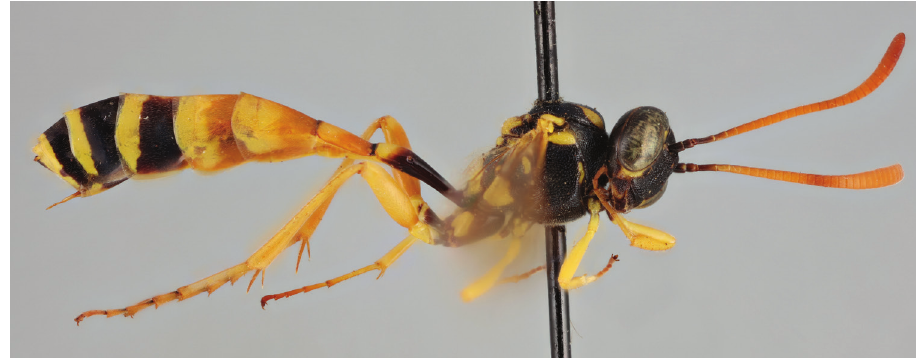
Figure 1. Hellwigia elegans , female habitus (Cyprus).